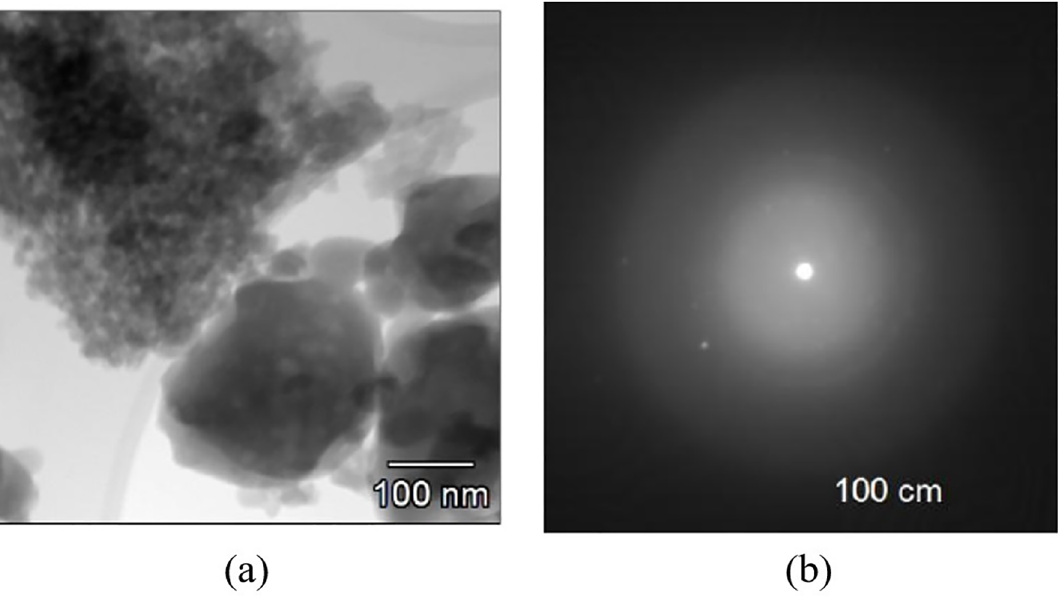
Figure 5. (a) TEM bright field image of the metakaolin-based geopolymer resin (SG) and (b) electron diffraction showing evidence of crystallinity.